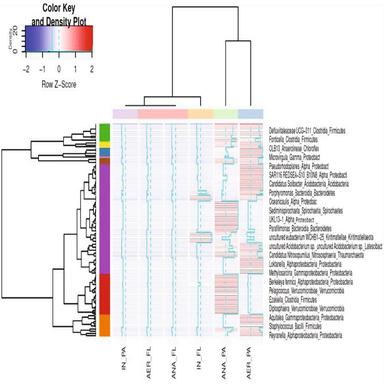
Heatmap of the most abundant taxa in the particle-attached bacterial fraction (100-fold higher of relative abundances in 16S libraries in PA than in FL) classified at genus, phylum, and class level. FL: Free-living bacterial fraction. PA: particle-attached bacterial fraction. ANA: anaerobic (denitrifying reactor). AER: aerobic (secondary reactor). IN: influent. Alpha: Alphaproteobacteria. Gamma: Gammaproteobacteria. Proteobact: Proteobacteria. See details in Table S3 (Supplementary Material).